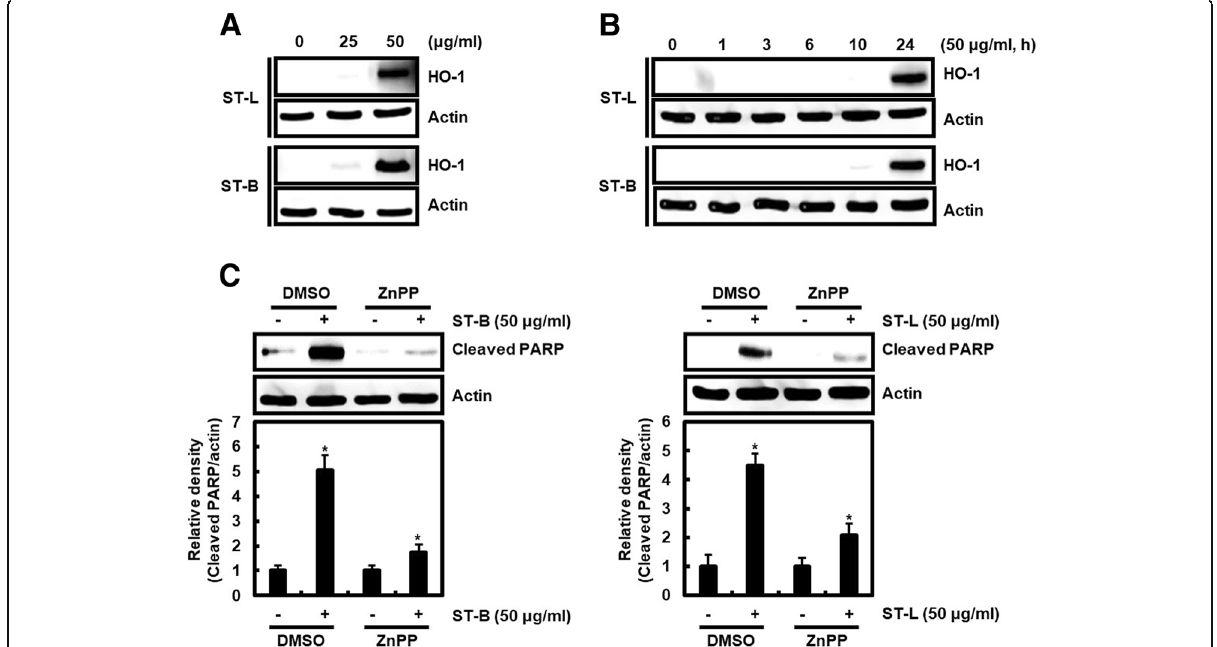
Fig. 5 STL and STB increase HO-1 expression. a SW480 cells were treated with STL and STB for 24 h. b SW480 cells were treated with STL and STB for the indicated times. c SW480 cells were treated with ZnPP (1 μ M) for 2 h and then co-treated with STL and STB for the additional 24 h. Actin was used as loading control. * P < 0.05 compared to the cells without STL and